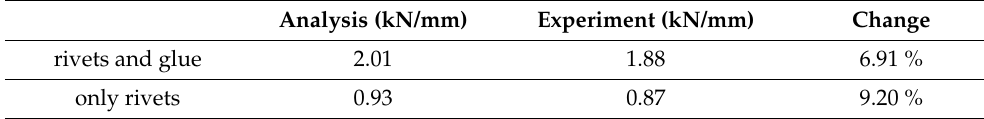
Table 2. Comparison of initial bending stiffness results for assembled truss core